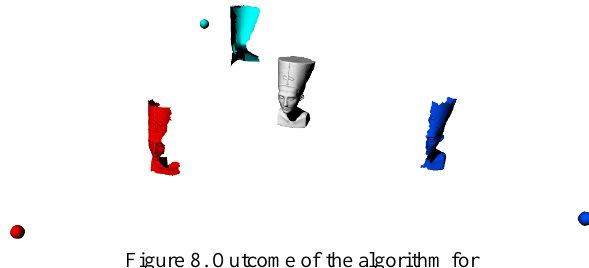
Figure 8. Outcome of the algorithm for a level of completeness of at least